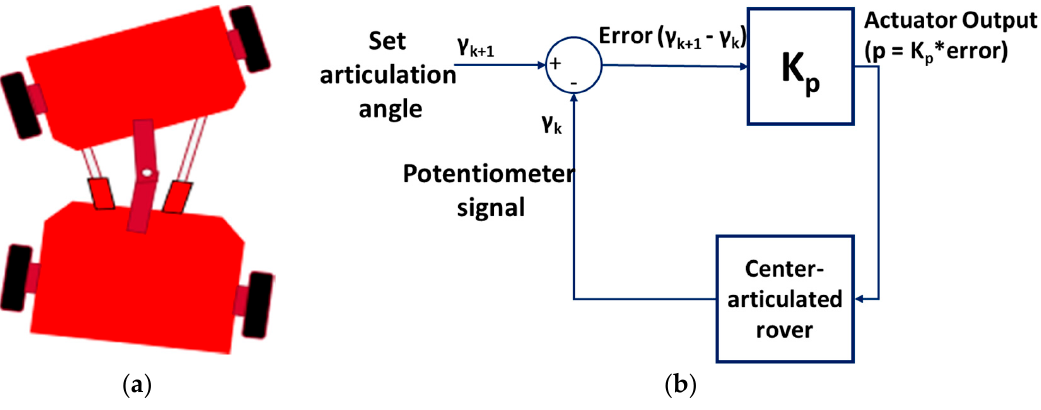
Figure 11. Proportional control of the articulation angle. ( a ) The rover when turning left; ( b ) the proportional control to achieve a targeted articulation angle.